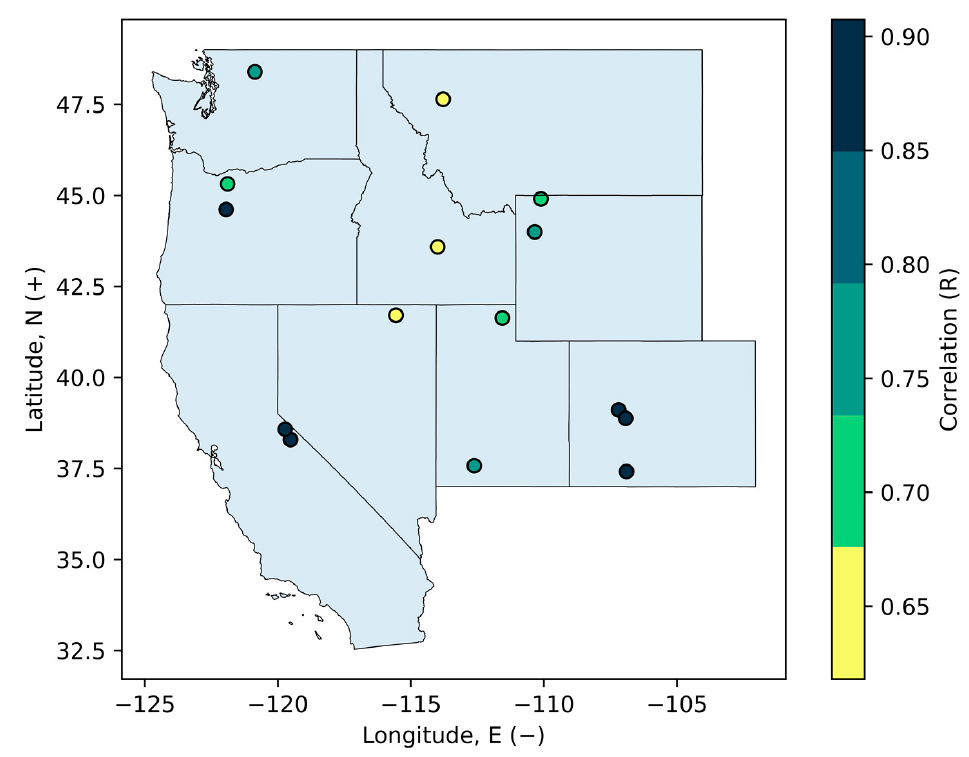
Figure 1. The 15 study basins spread across eight western states. Correlation values between DSD mean and yearly seasonal water supply are calculated at basin-wide level, marked at the outlet location for each basin. Table 1. Description of study basins and relevant a tt ributes. SWE/P is de fi ned as the average ratio of 1 April SWE to cumulative precipitation, as recorded at each SNOTEL station, for the water years 1985–2020. The USGS gage names have been abbreviated for clarity.